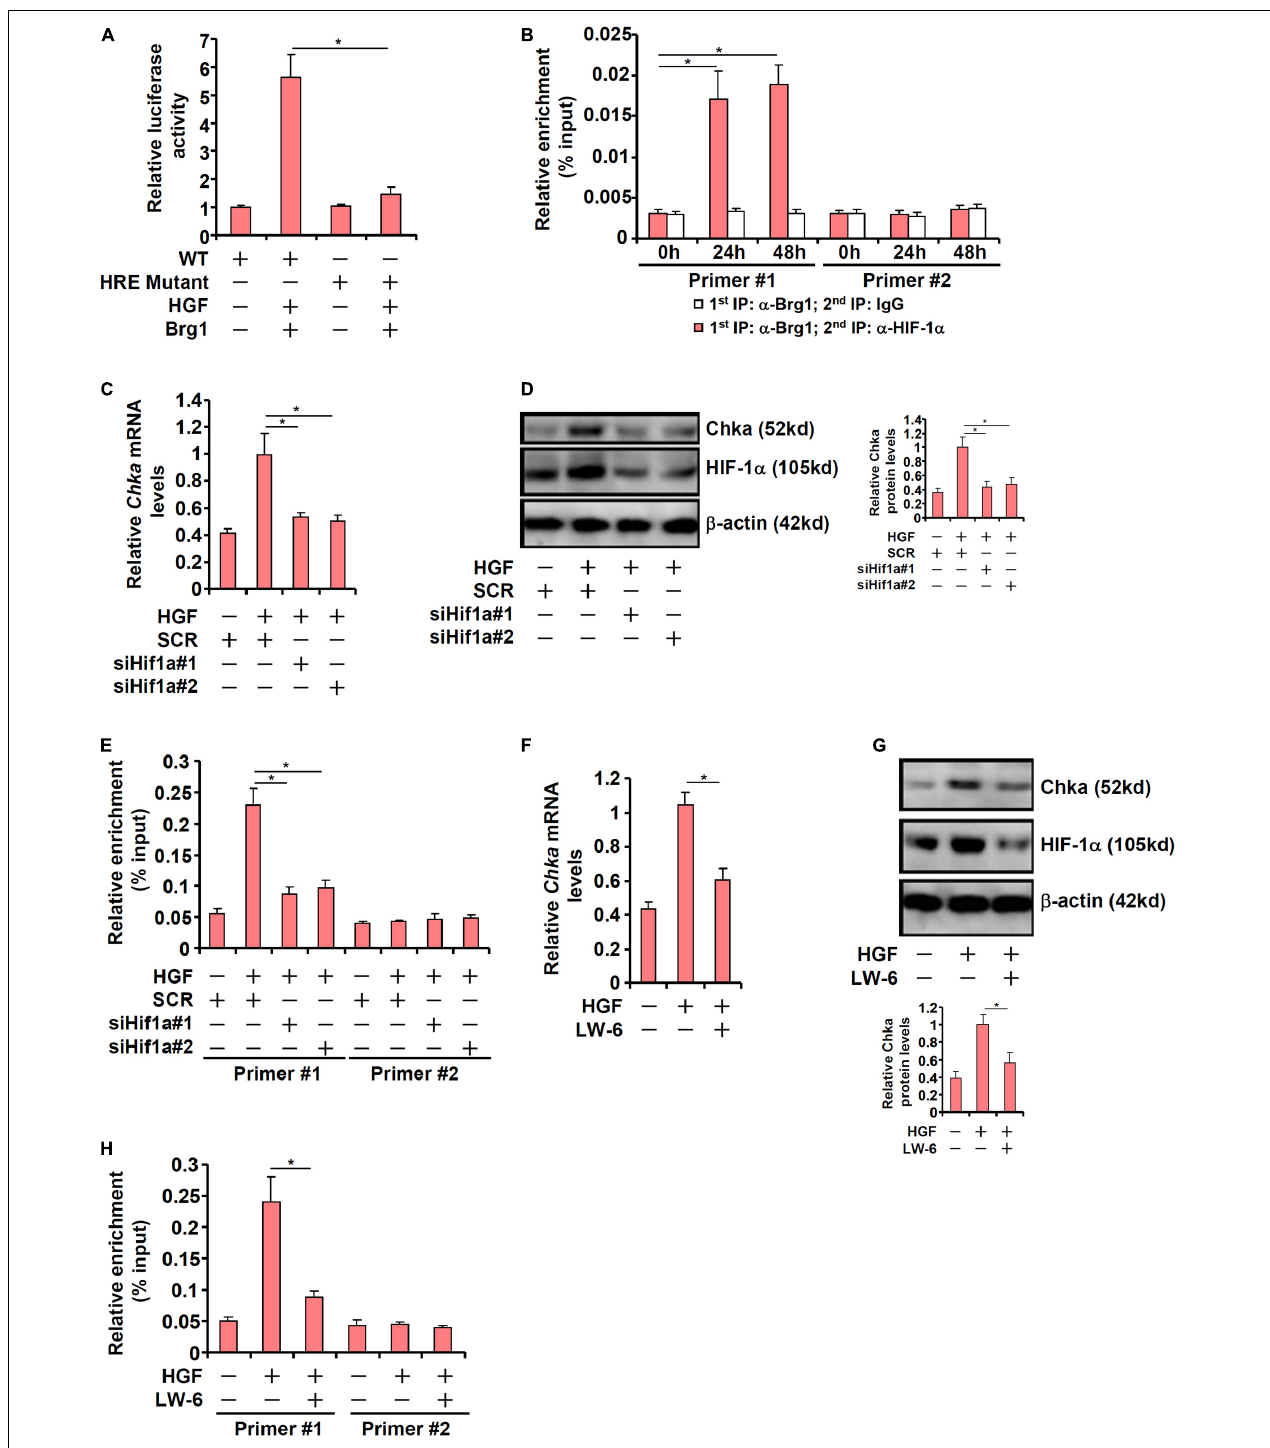
FIGURE 5 | Hypoxia-inducible factor 1 alpha recruits Brg1 to activate Chka transcription in hepatocytes. (A) Wild type or mutant Chka promoter-luciferase construct was transfected into primary hepatocytes followed by HGF treatment. Luciferase activities were normalized by protein concentration and GFP fluorescence. (B) Primary murine hepatocytes were treated with HGF and harvested at indicated time points. Re-ChIP assay was performed with indicated antibodies. (C–E) Primary hepatocytes were transfected with indicated siRNAs followed by treatment with HGF. Chka expression was examined by qPCR and Western blotting. ChIP assay was performed with anti-Brg1. (F–H) Primary hepatocytes were treated with HGF in the presence or absence of LW-6 (5 µ M). Chka expression was examined by qPCR and Western blotting. ChIP assay was performed with anti-Brg1. * p < 0.05.